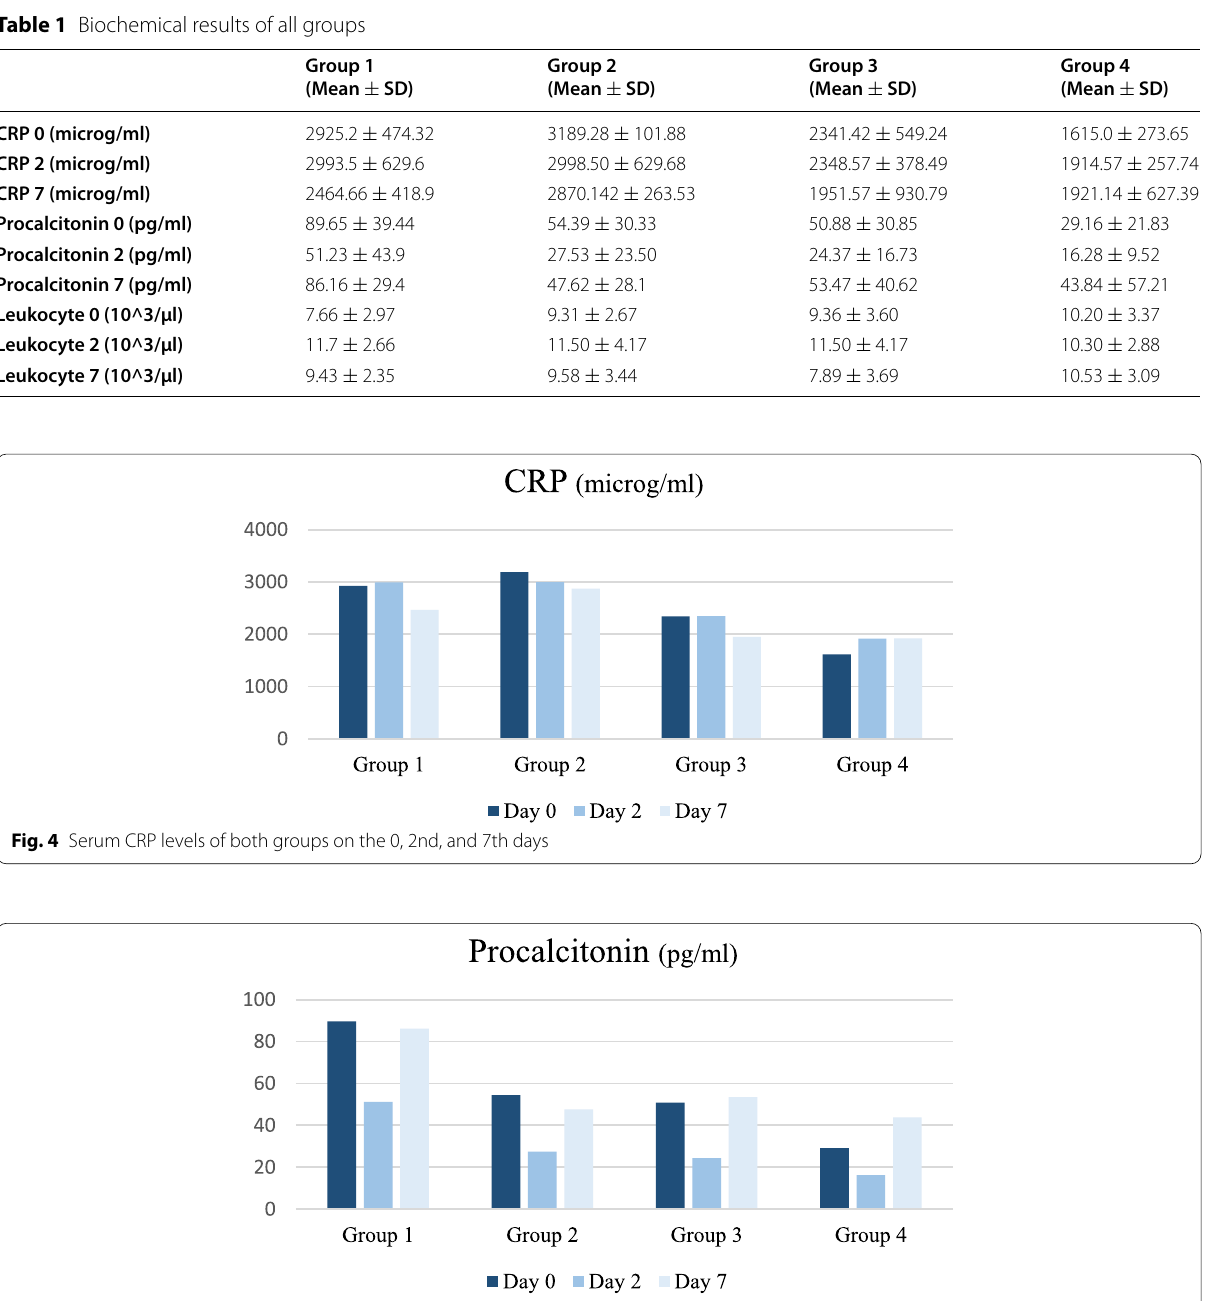
Fig. 5 Serum procalcitonin levels of both groups on the 0, 2nd, and 7th